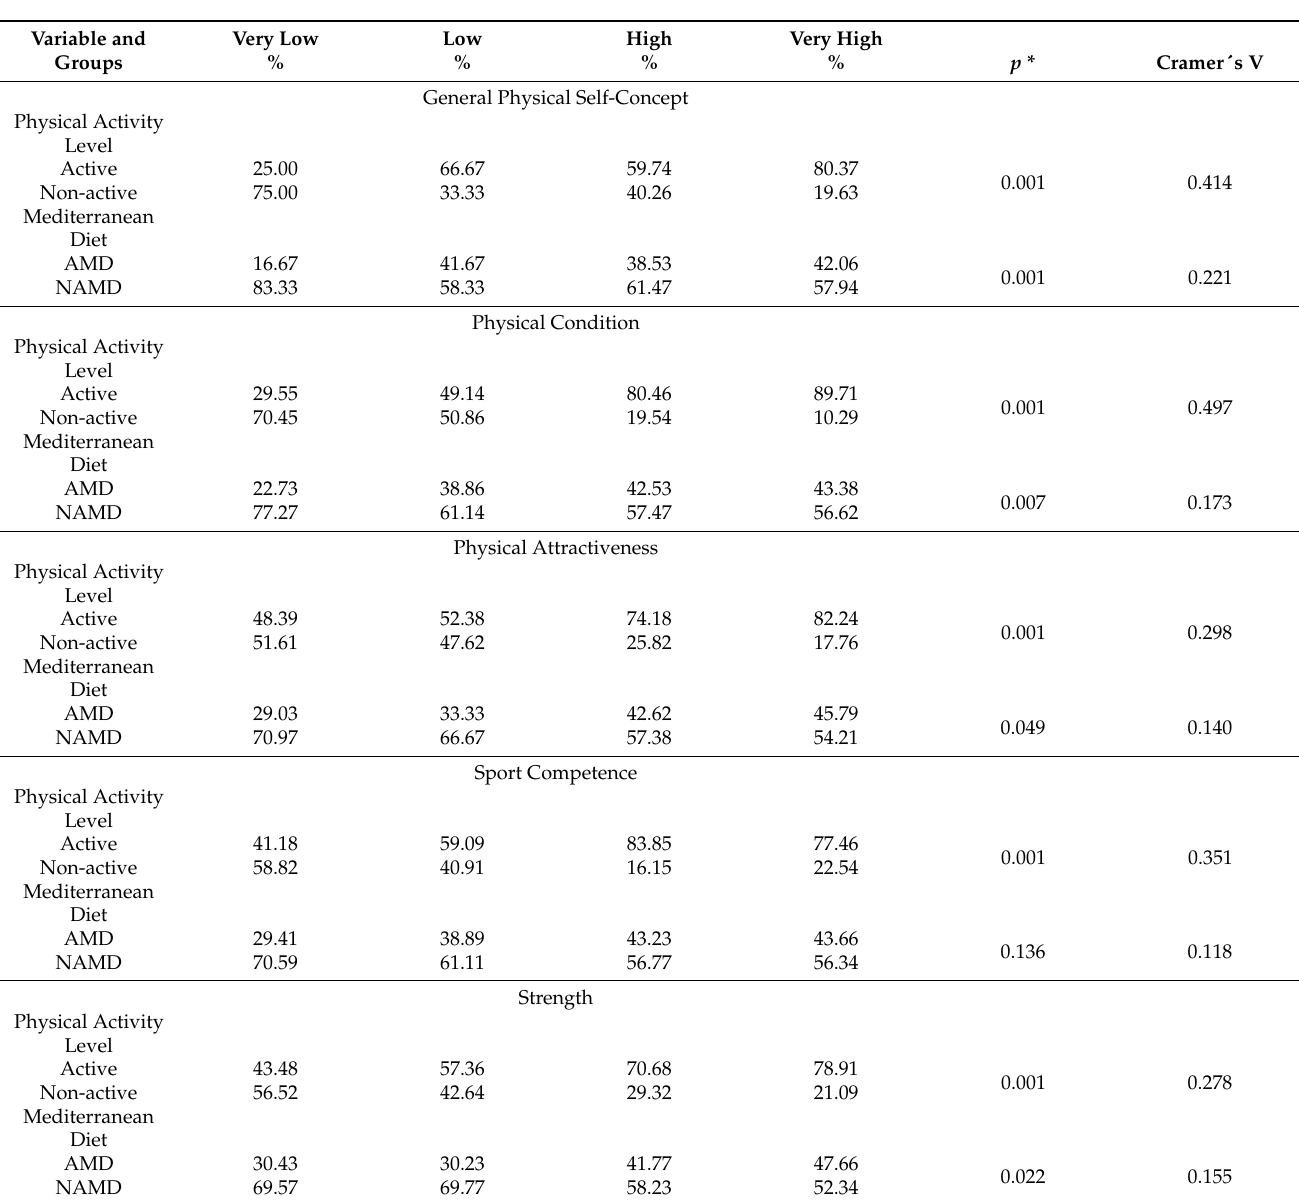
Table 3. Association between level-groups of each PSC-Q dimension with physical activity and adherence to the Mediterranean diet